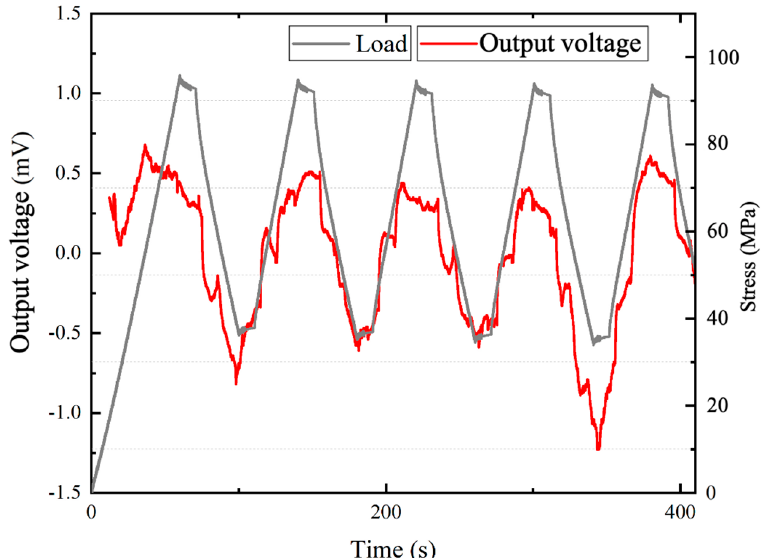
Figure 10. Three-point bending test: measured peak-to-peak output voltage.